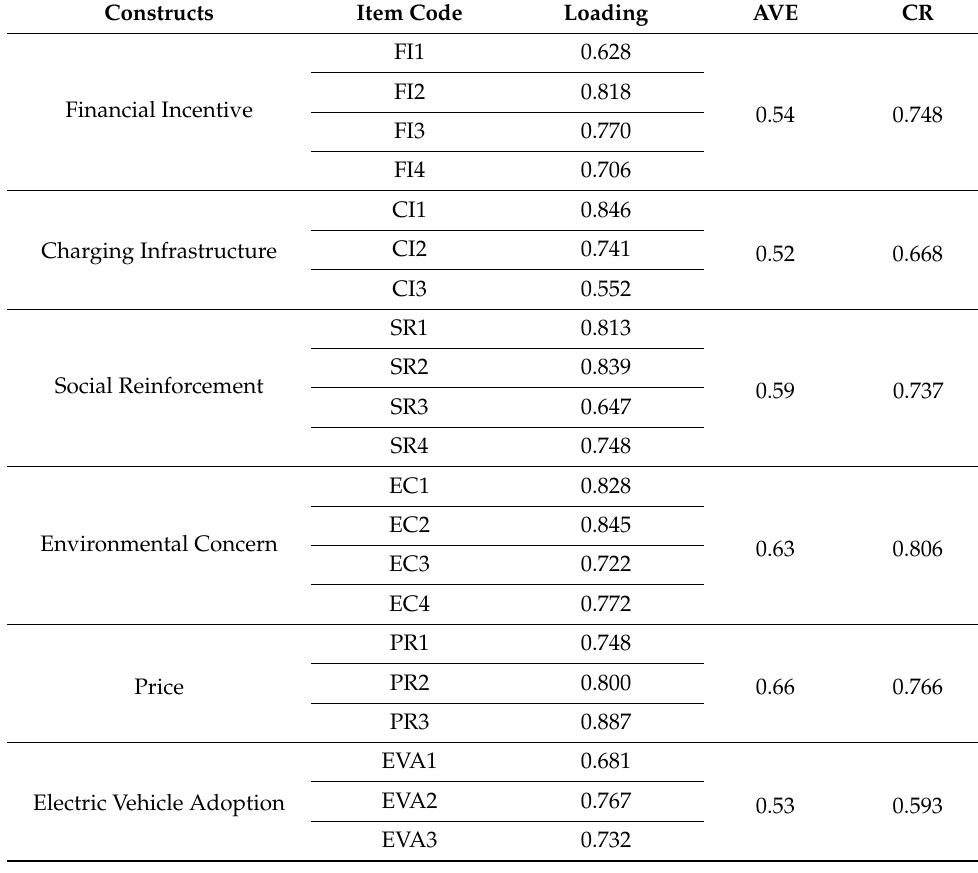
Table 3. Construct Reliability and Validity.